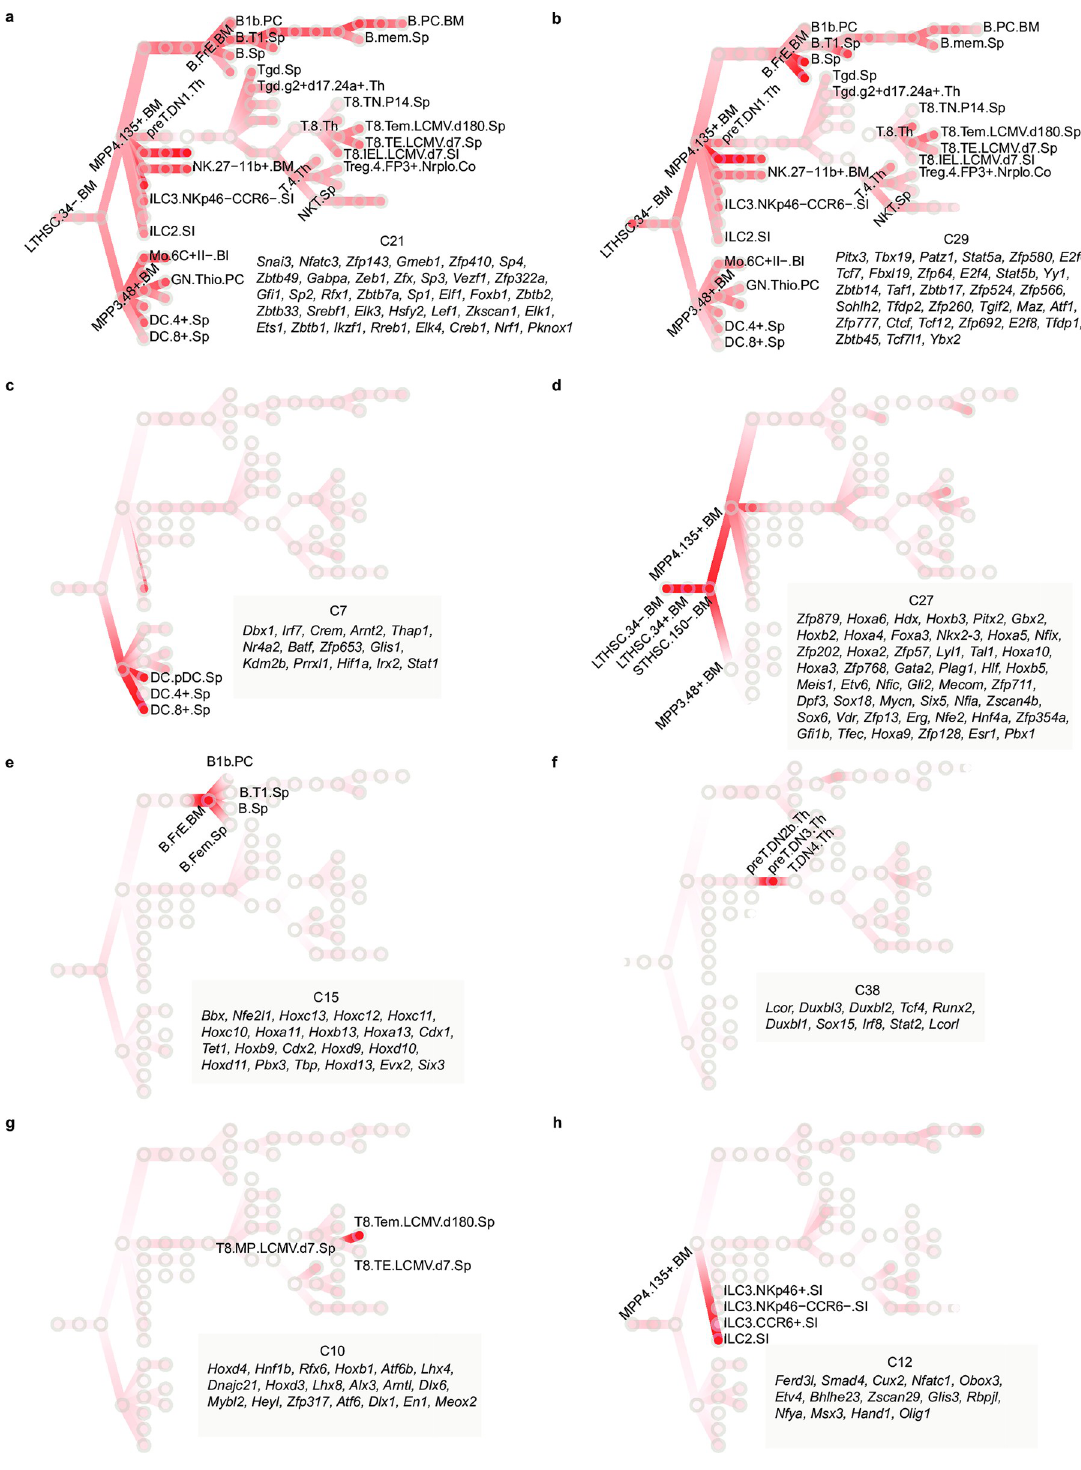
Fig 5. Transcriptional waves regulate the development of the mouse immune system. (A,B) Two transcriptional waves C21 and C29, which are active in all developmental stages. (C,D) Two cell lineage-specific transcriptional waves. C7 is active in DC lineage and C27 is active in stem cells. (E-H) Four examples of stage-specific waves in immune cell development. C15 is active in B.FrE.BM; C38 is active in preT.DN3.Th; C10 is active in T8.Tem.LCMV.d180.Sp; C12 is active in ILC2.SI. Circles in each panel represent specific cells in the developmental stages. Color indicates normalized PageRank scores with red displaying high values (color bar is the same as Fig 4). TF members of the cluster are shown on the bottom right of the panel. https://doi.org/10.1371/journal.pcbi.1010116.g005 PLOS Computational Biology | https://doi.org/10.1371/journal.pcbi.1010116 September 26,